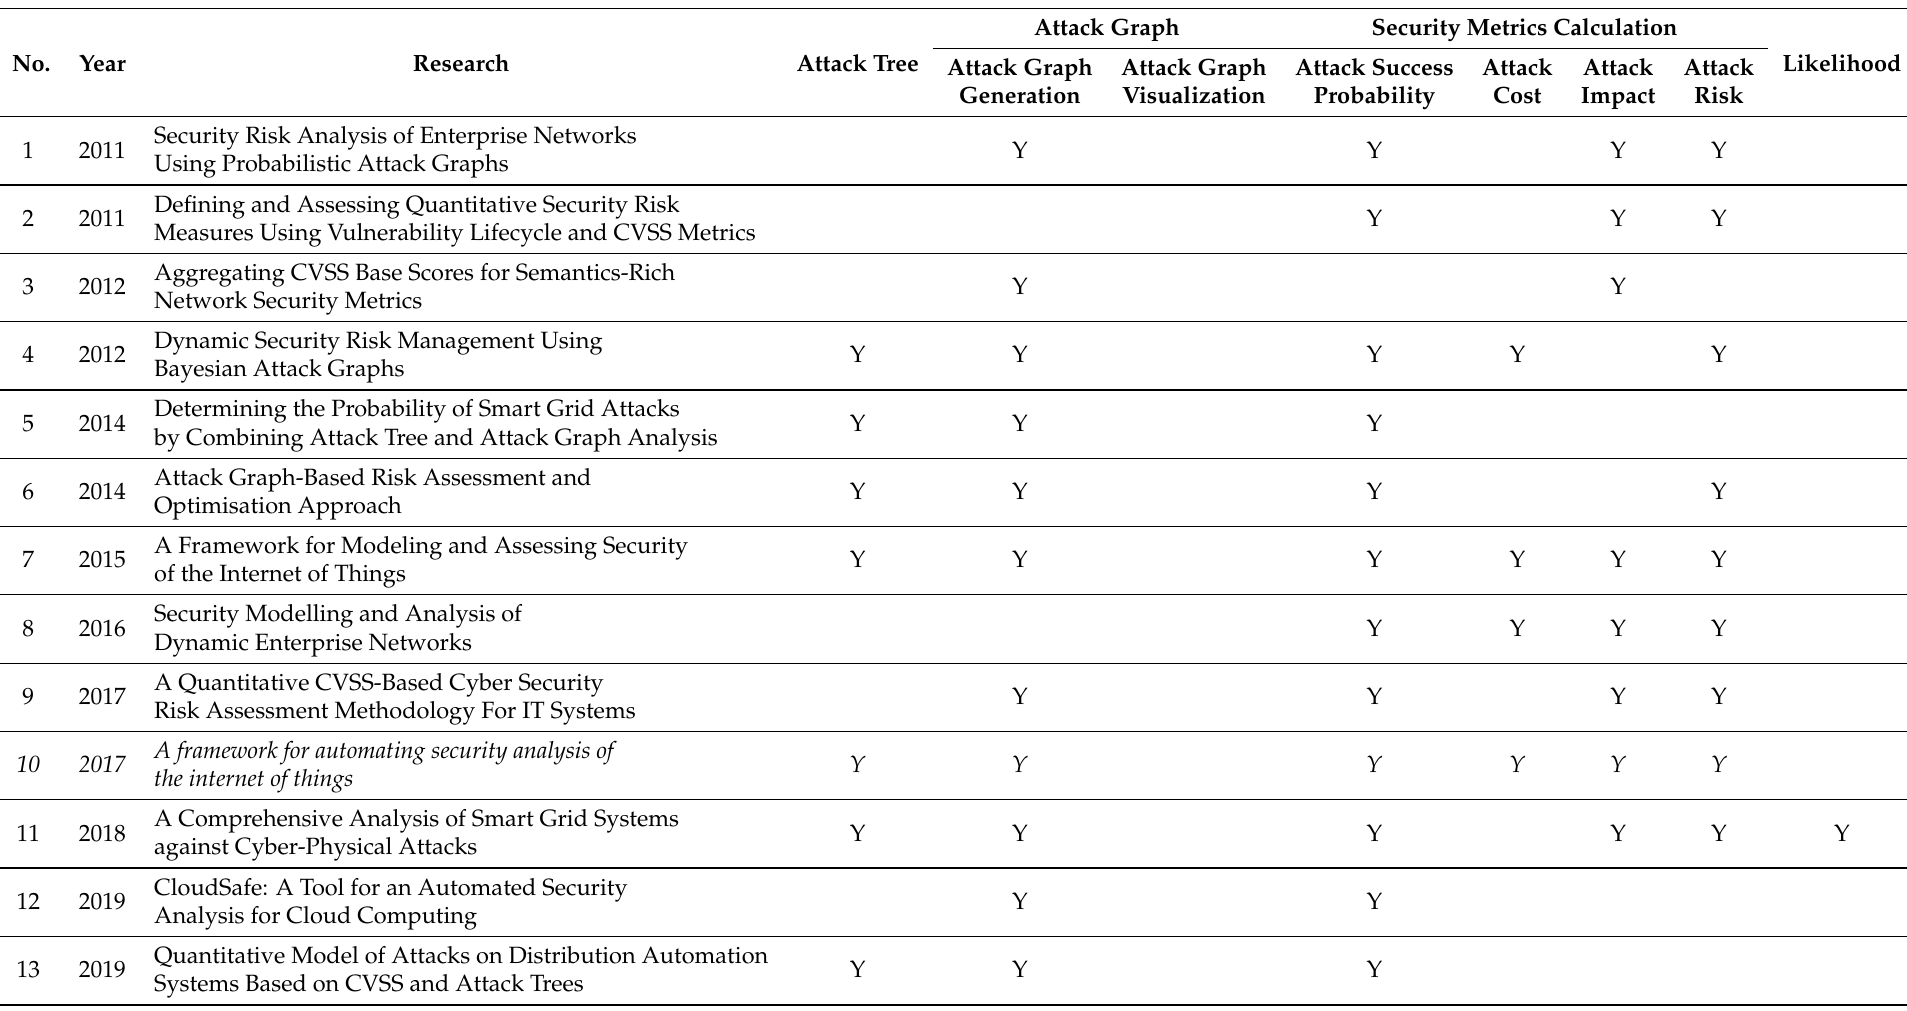
Table 6. Functionality evaluation of GridAttackAnalyzer (a blank cell indicates a functionality/aspect that is not present).